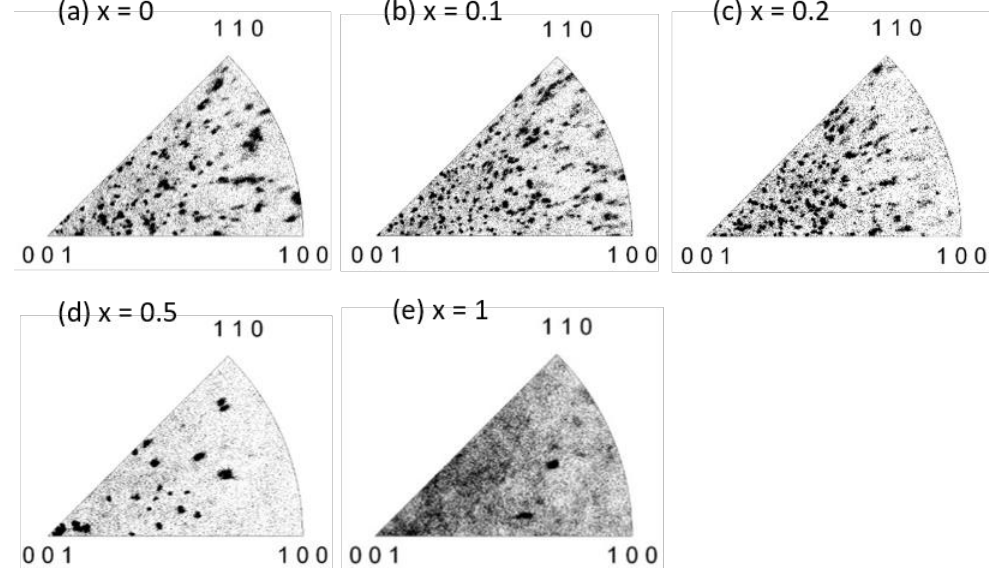
Figure 3. EBSD inverse pole figure unit triangle of C x S 1–x BT layer in the FeFET stacks, with ( a ) x = 0; ( b ) x = 0.1; ( c ) x = 0.2; ( d ) x = 0.5; and ( e ) x = 1. Materials 2019 , 12 , x FOR PEER REVIEW